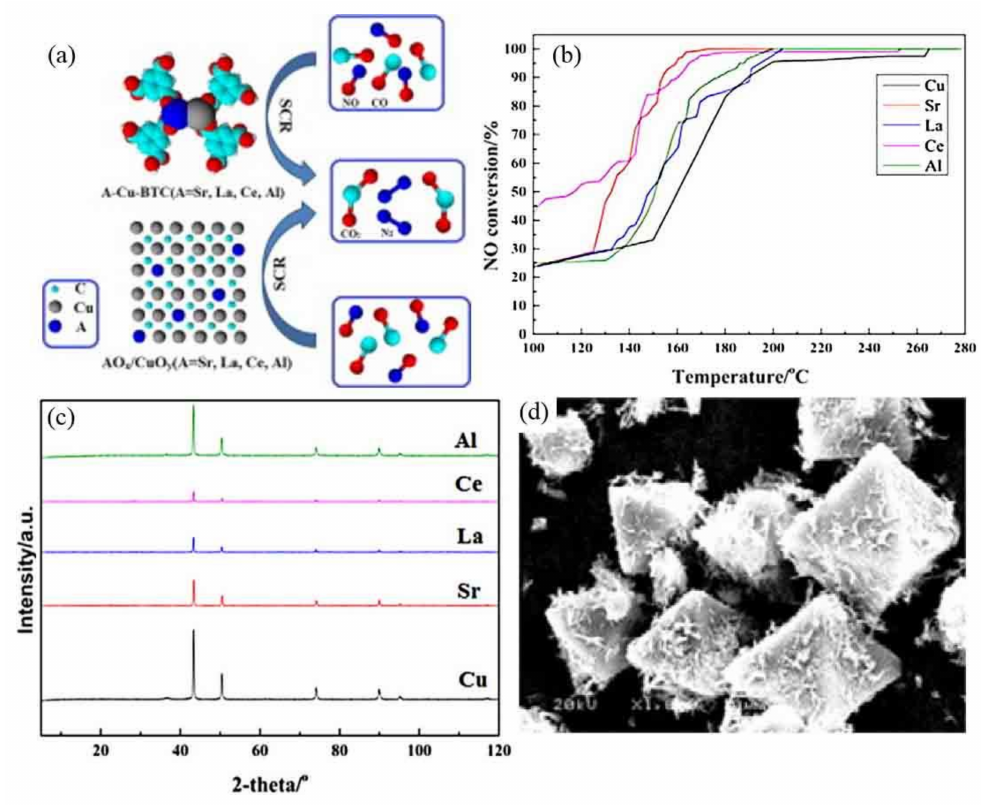
Figure 1. ( a ) Adsorption process and reaction mechanism of NO on A-Cu-BTC, ( b ) NO conversion with di ff erent metal dropping, ( c ) XRD images of metal doped Cu-BTC, and ( d ) SEM images of A-Cu-BTC [40]. Reproduced with the permission from Ref. [40], Copyright 2016,